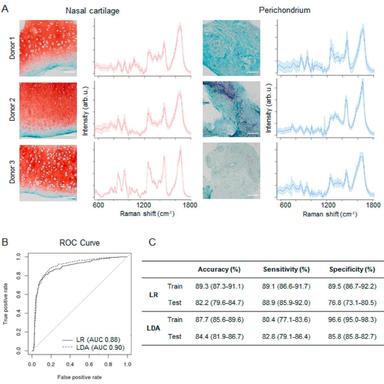
(A) Safranin O staining and Raman spectra of native nasal cartilage and perichondrium (three of the eight donors are pictured; scale bar is 200 μm). (B) The receiver operating characteristic (ROC) curve for the logistic regression (LR) and linear discriminant analysis (LDA) models for the test dataset along with the area under the curve (AUC) values. (C) Training and test accuracy, sensitivity, and specificity of the LR and LDA models along with the 95% confidence intervals.